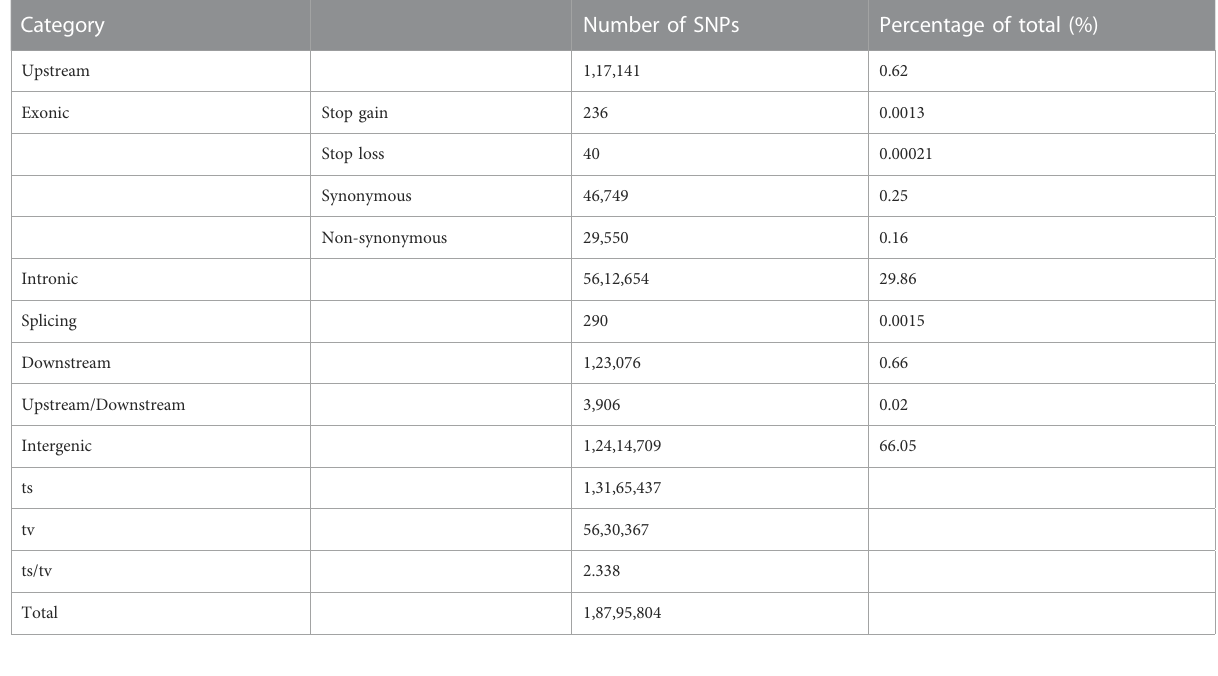
TABLE 1 Summary and annotation of SNPs.